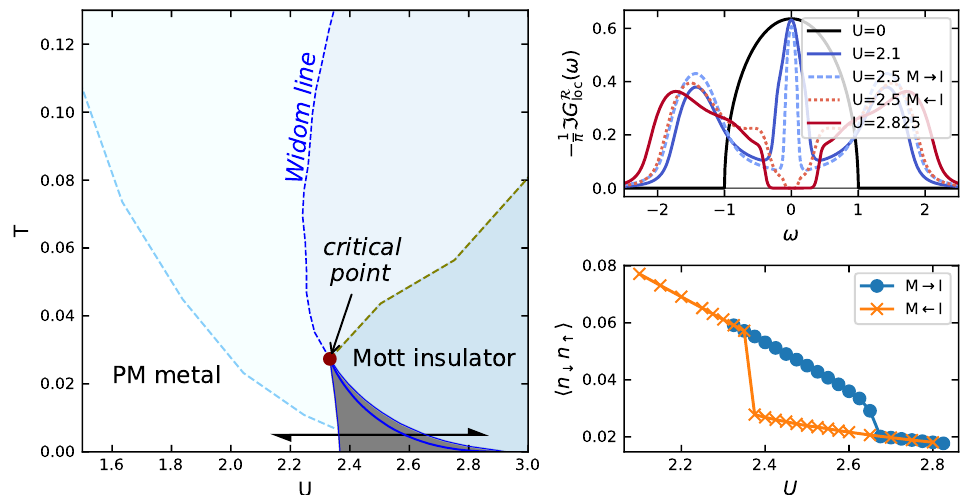
Figure 1: Left: Schematic DMFT phase diagram of the half-filled Hubbard model on a Bethe lattice with unitary half bandwidth. The thick solid blue line marks the first ( T ) , the gray-shadowed the coexistence region between U order MIT, U c ( T ) , both taken from [ 29 ] . The local moment formation, as estimated in [ 15 ] 9 , is U c 2 marked by the azure dashed line; the Widom line (blue dashed) is taken from [ 48 ] , while the opening of the Mott gap (olive dashed) has been estimated by [ 49 ] . The black double arrow marks the parameter paths we focus on in our work. Right : Evolution of the local spectral function (upper panel) and of the double occupancy (lower panel) computed in DMFT along the path shown in the phase diagram on the